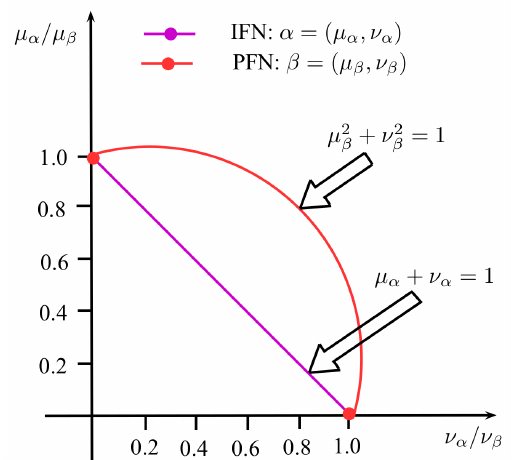
Figure 1. Comparison of spaces of the intuitionistic fuzzy numbers (IFNs) and the Pythagorean fuzzy numbers